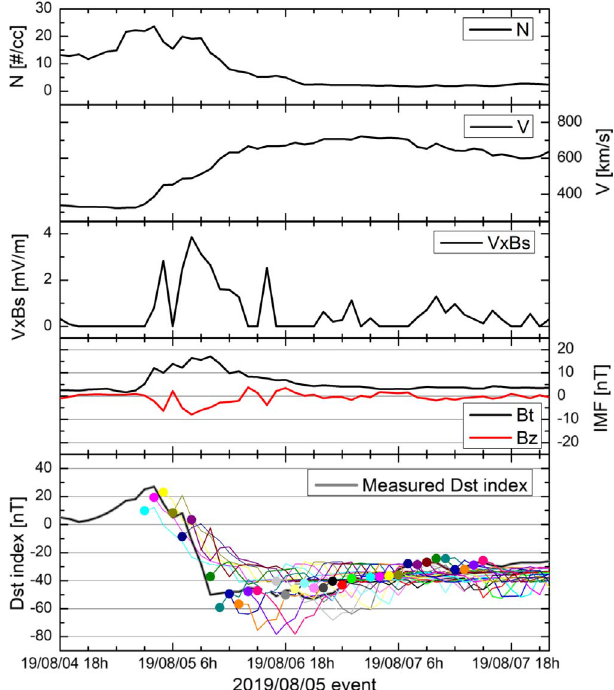
Fig. 6. Example of predicting the geomagnetic storm that occurred by CIR on 5 August 2019. Same format with Figure 5.